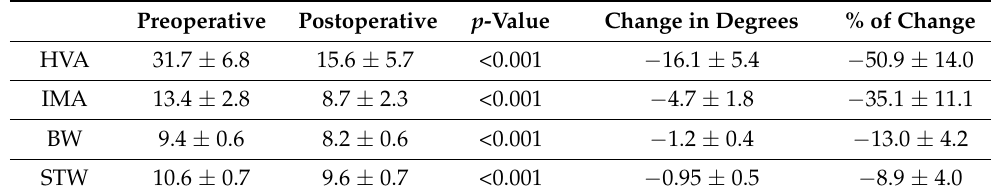
Table 2. Changes in preoperative and postoperative hallux valgus